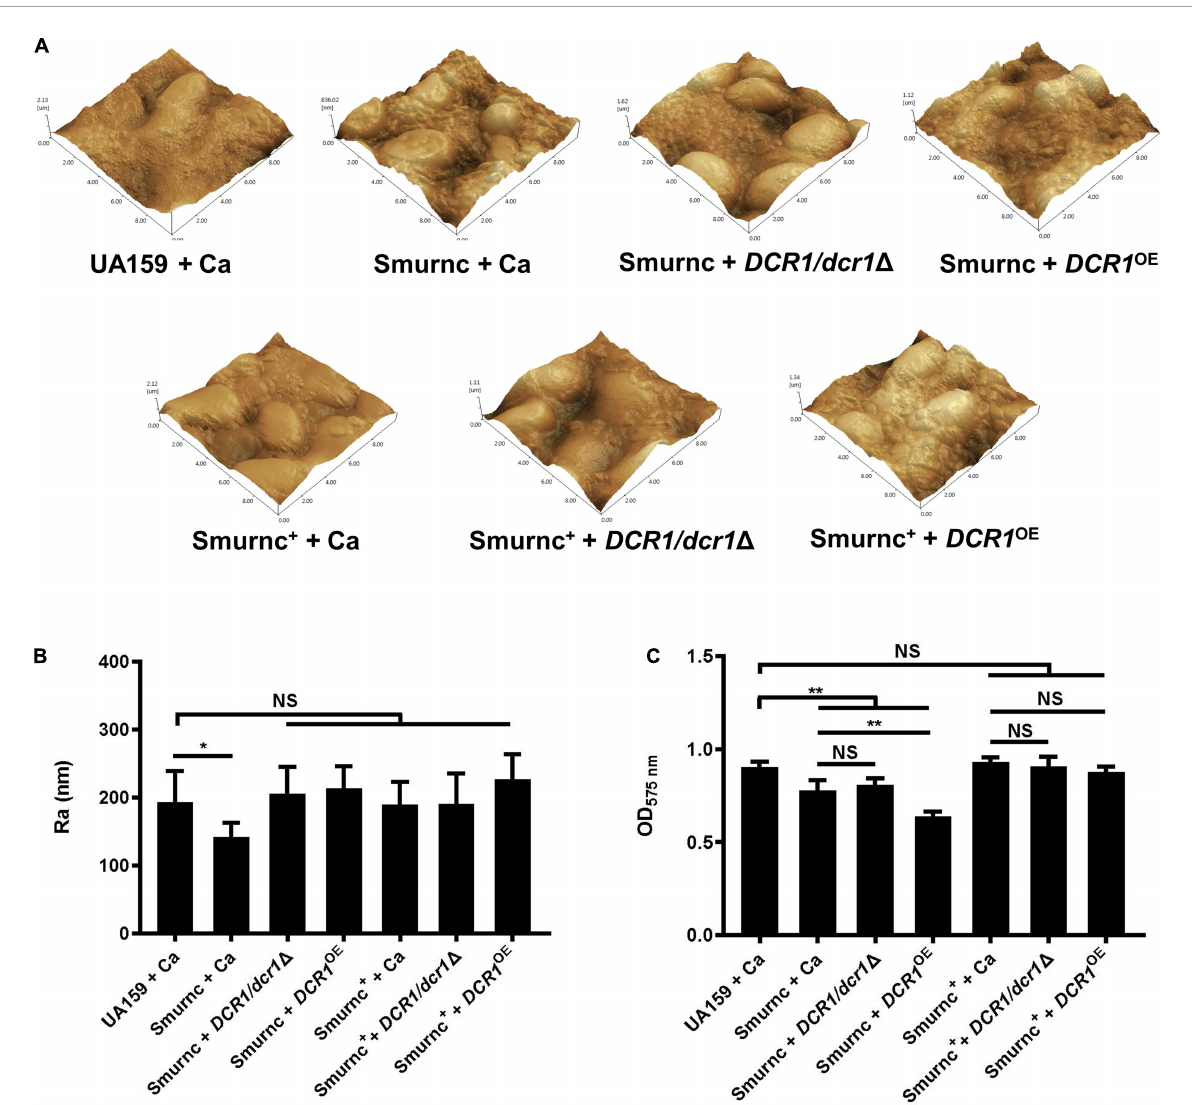
FIGURE4 The genes coding RNase III modulated the formation and surface characteristics of cross-kingdom biofilms. (A,B) Biofilm morphology and surface roughness (Ra) were tested by AFM. (C) Biofilm volume was examined by the CV microtiter assay. Experiments were performed in biological triplicate. * P < 0.05, ** P <